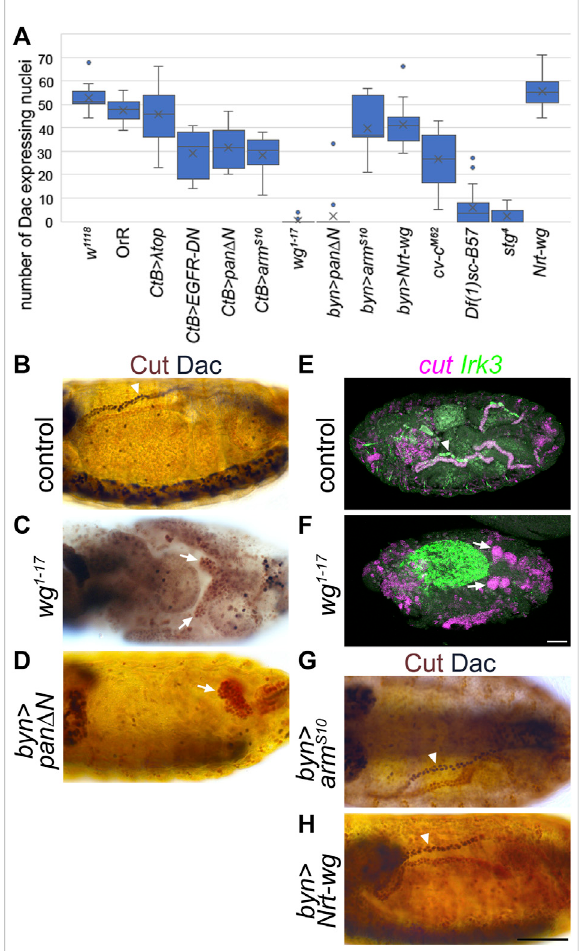
Wingless is required for expression of distal tubule markers. (A) Countsof thenumberofMalpighiantubulecell nucleiexpressingdistal marker, Dachshund. Generally, for each embryo the number of nuclei staining with anti-Dac in a single anterior Malpighian tubule were counted. This was not possible in all genotypes depending on the morphology, and in this case the count was from a single tubule if discernible,ortheentiremassoftubulecellsifnot. W 1118 (control)n=16. OrR(control)n=10. CtB > λ top n=20, p =0.087. CtB > EGFR-DN n=12, p < 0.00001***. CtB > pan Δ N = 12, p = 0.000012***. CtB > arm S10 n = 16, p < 0.00001***. Wg 1-17 n=20, p < 0.00001***. Byn > pan Δ N =19, p < 0.00001*** ( p = 0.81 comparing to wg 1-17 ). Byn > arm S10 n = 7, p = 0.040*. Byn > Nrt-wg n=13, p =0.00070***. Cv-c M62 embryosn=16, p < 0.00001*** ( p < 0.00001*** comparing to wg 1-17 ). Df(1)sc-B57 n = 20, p < 0.00001*** ( p = 0.00018*** comparing to wg 1-17 ). Stg 4 n = 22, p < 0.00001*** ( p = 0.062 comparing to Df(1)sc-B57 , p = 0.020* comparing to wg 1-17 ). Nrt-wg n = 6, p = 0.28. N numbers represent number of embryos. p -values calculated using Mann-Whitney U test comparing to the w 1118 control group, except where stated otherwise. (B – D) and (G – H) ~Stage16embryosstainedtoshowMpTnuclei(anti- Cut, brown) and the nuclei of cells from the distal MpT segment (anti- Dac,black,arrowheads).ArrowsindicateMpTs,incaseswhereanti-Dac staining is absent. (E, F) ~stage 16 – 17 embryos stained for cut and Irk3 mRNA. (B) Control embryo ( w 1118 ). (C) Homozygous wg 1-17 embryo. (D) Byn-Gal4 > UAS-pan/dTCF Δ N embryo. (E) Control ( w 1118 ) embryo. (F) Homozygous wg 1-17 embryo. (G) Byn-Gal4 > UAS-arm S10 embryo.